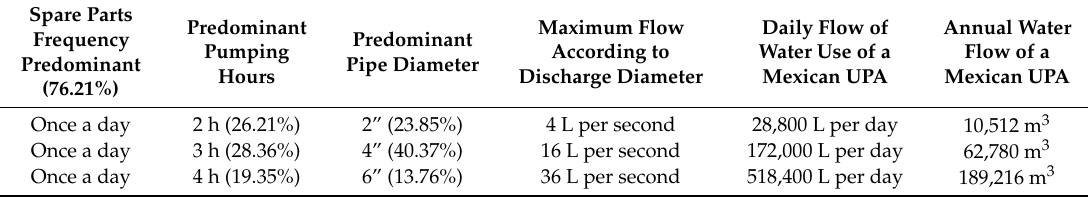
Table 3. Estimate of water use, according to discharge diameter and replacement